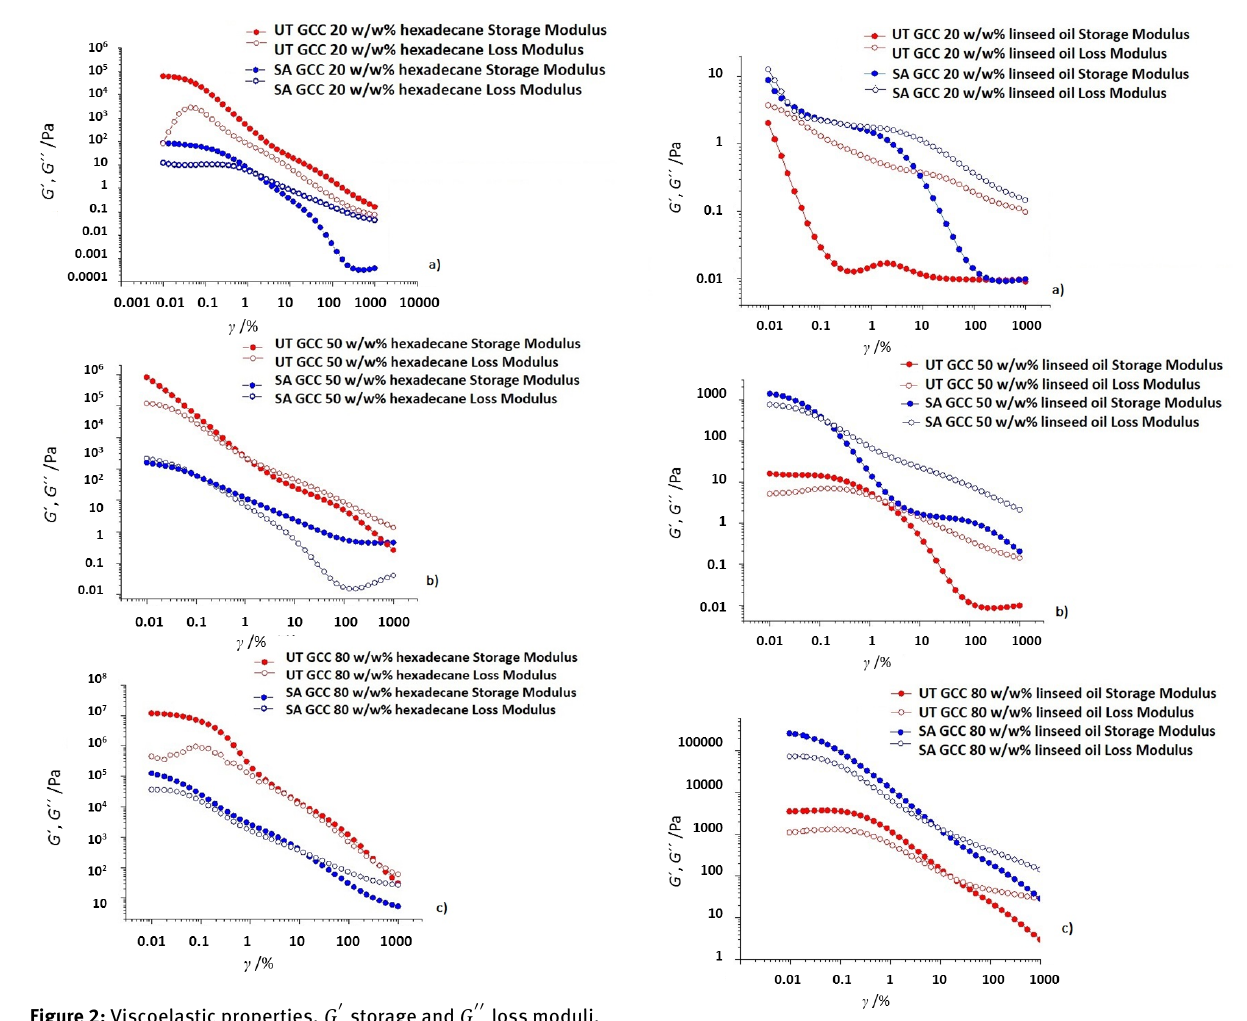
Figure 3: Viscoelastic properties of sample suspensions in linseed oil under oscillatory strain at constant angular frequency, ω = 0.1 s −1 (rad · s −1 ): (a) 20 w/w%, (b) 50 w/w%, and (c) 80 w/w% solids